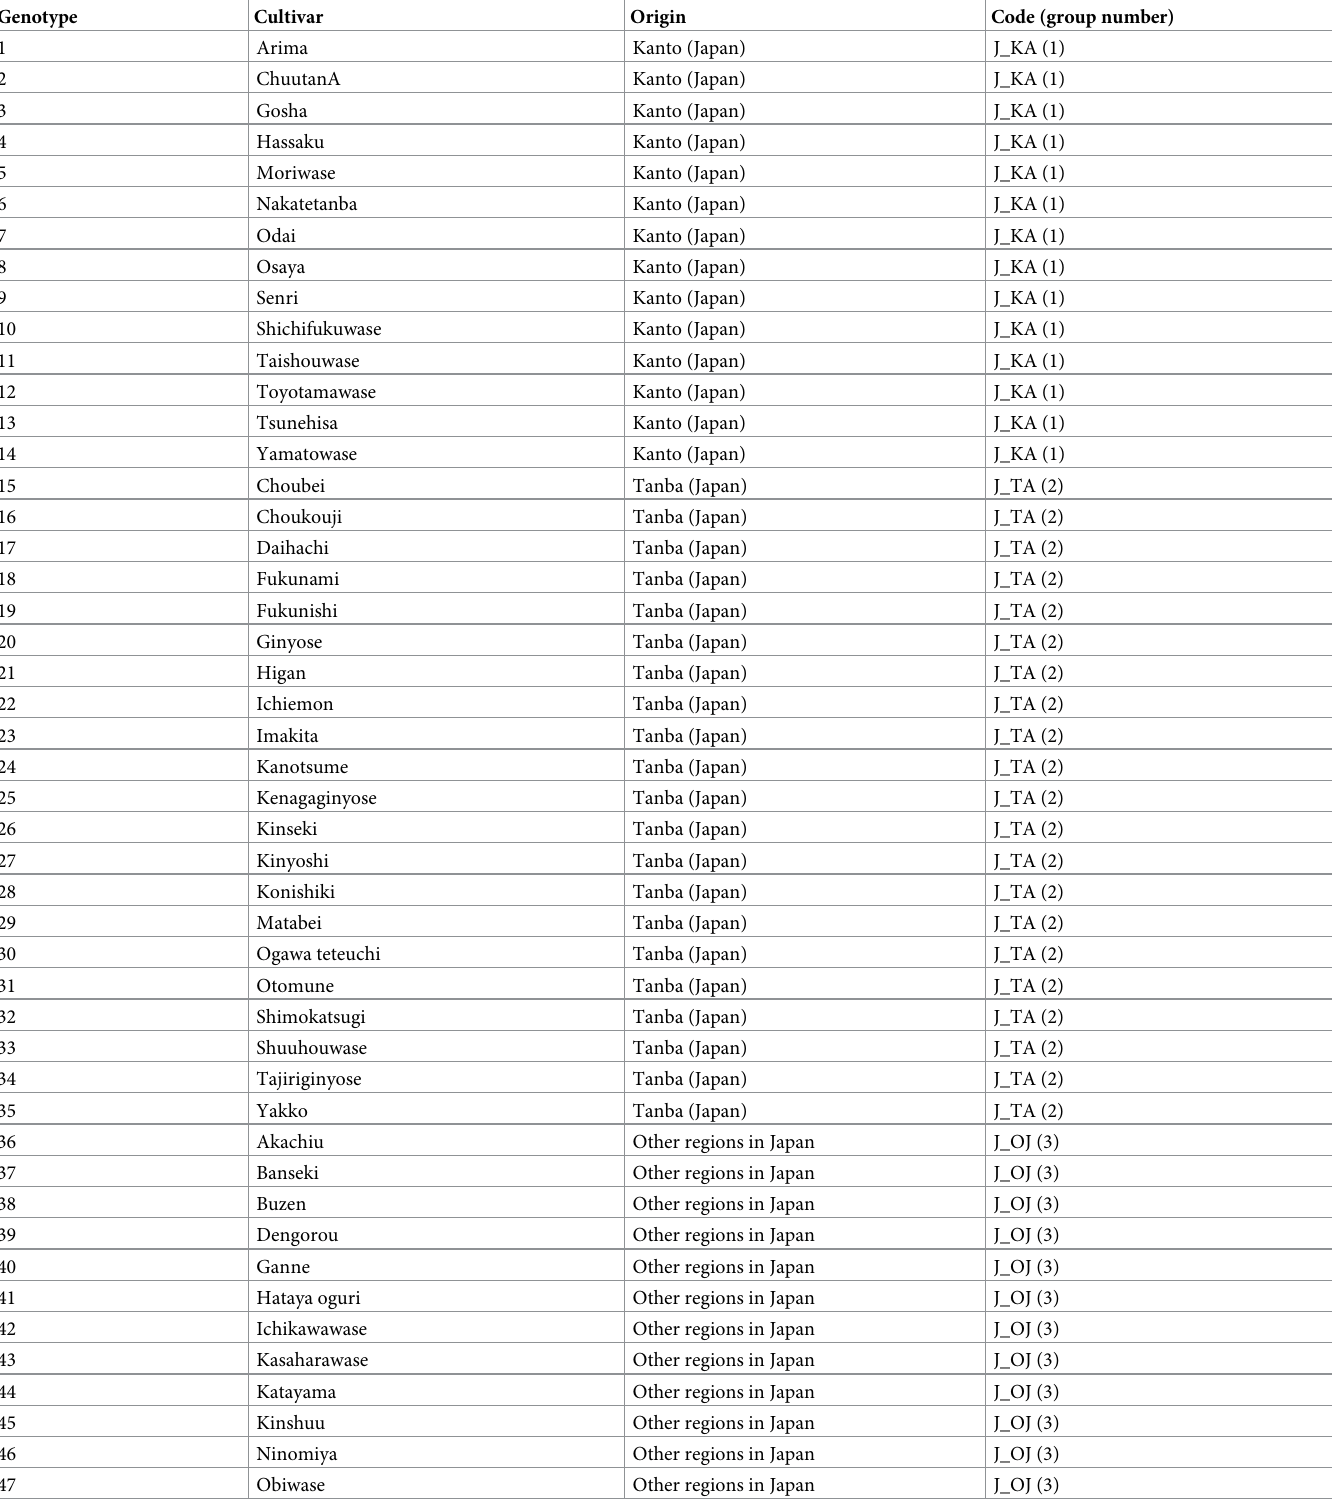
Table 1. Names, accession numbers, and genotype information for the 230 cultivars used in this study.